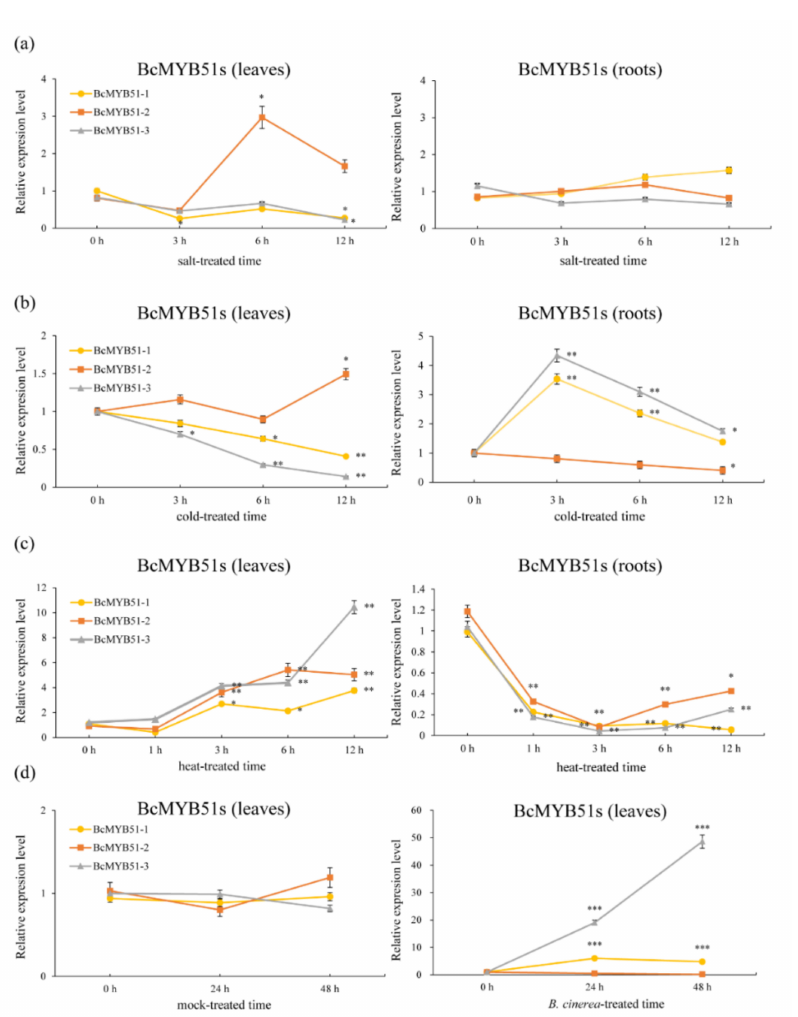
Figure 4. The expression patterns of BcMYB51s under abiotic and biotic stress. ( a – c ) The relative expression level of BcMYB51s upon salt ( a ), cold ( b ), and heat ( c ) treatment in leaves and roots of NHCC ‘suzhouqing’. ( d ) The relative expression level of BcMYB51s upon B. cinerea infection in leaves of NHCC ‘suzhouqing’. The data are the mean ± SD of three biological replicates. * p <